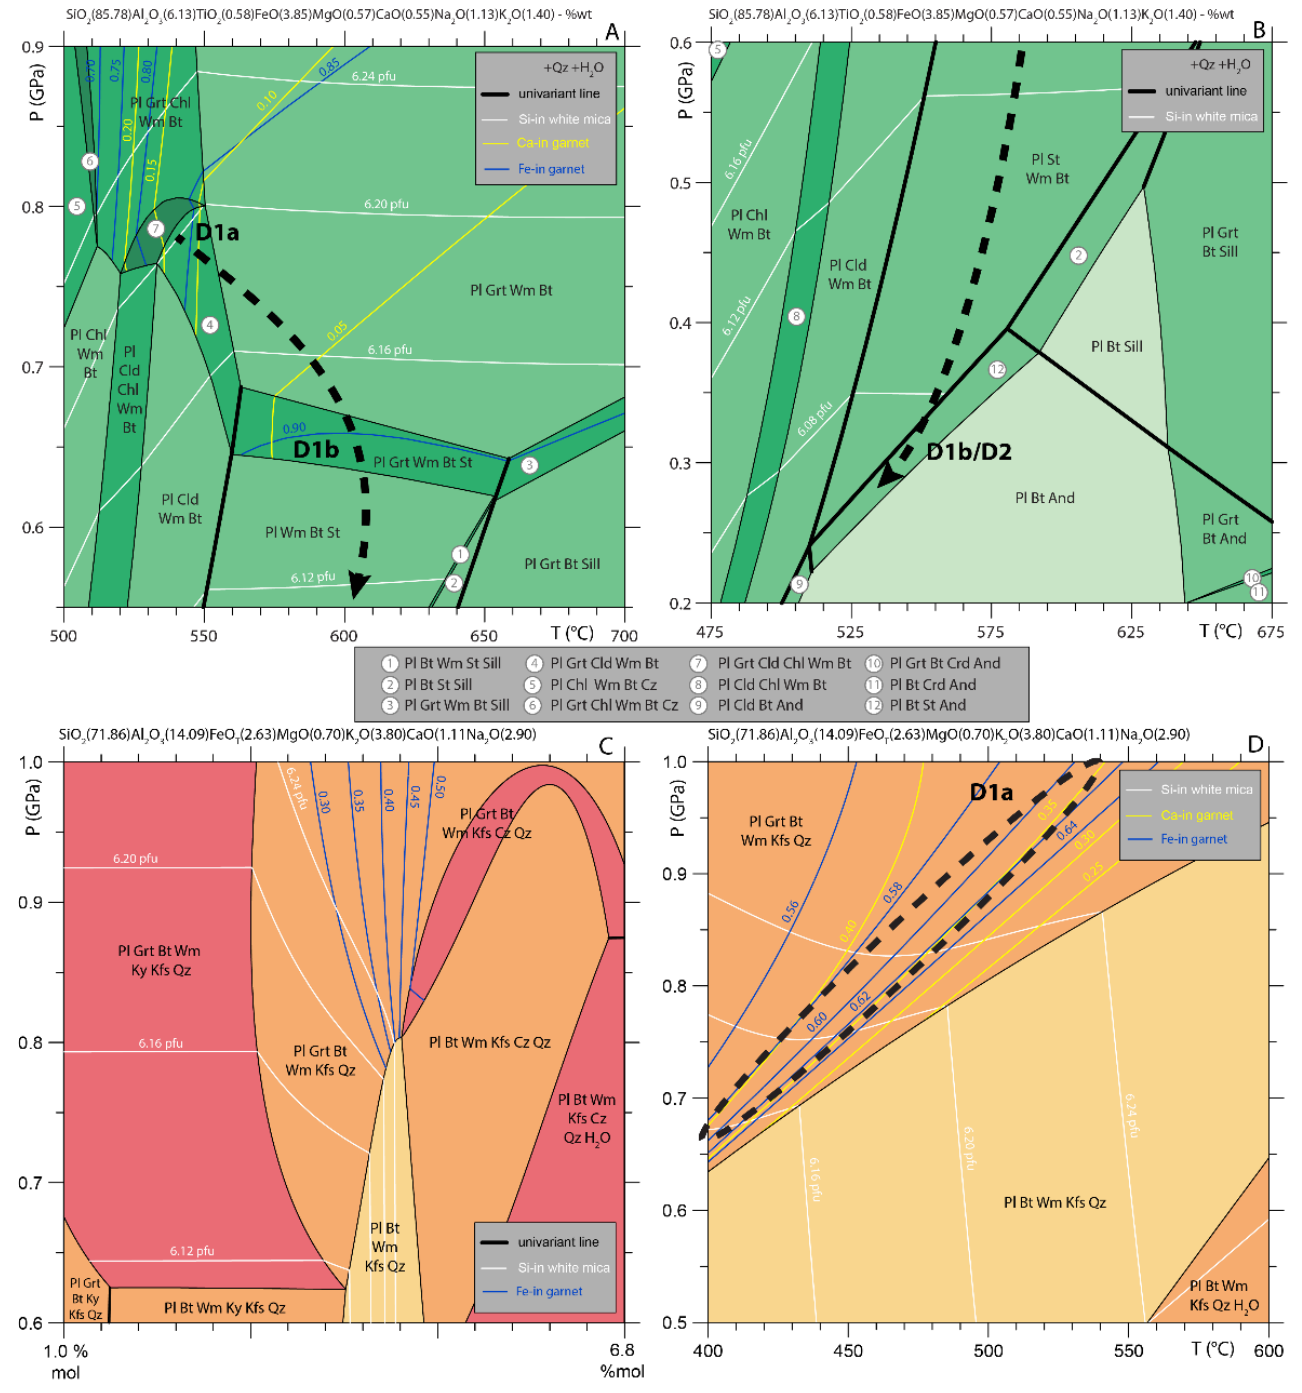
Figure 9. P-T and P-X pseudosections calculated in the CNKFMASH system for metapelites ( A , B ) and metagranitoids ( C , D ) in the SCB. Bulk compositions are from [97]. Fields are colored as function of variance. Si-in white mica, Ca-in garnet, and Fe-in garnet isopleths are added. P-T accountable for D1a to D2 deformation stages are highlighted by dotted ellipses and lines.